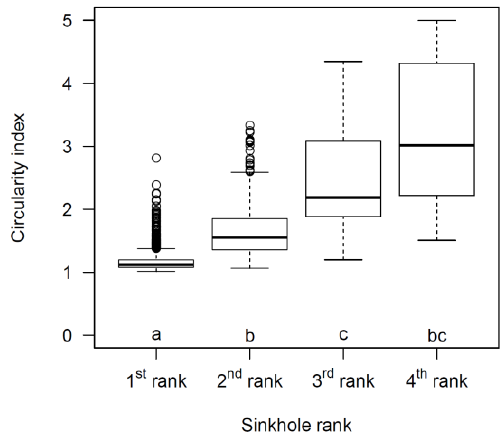
Figure 3. Elongation ratio R e ; same letter means no difference according to Kruskal-Wallis test.